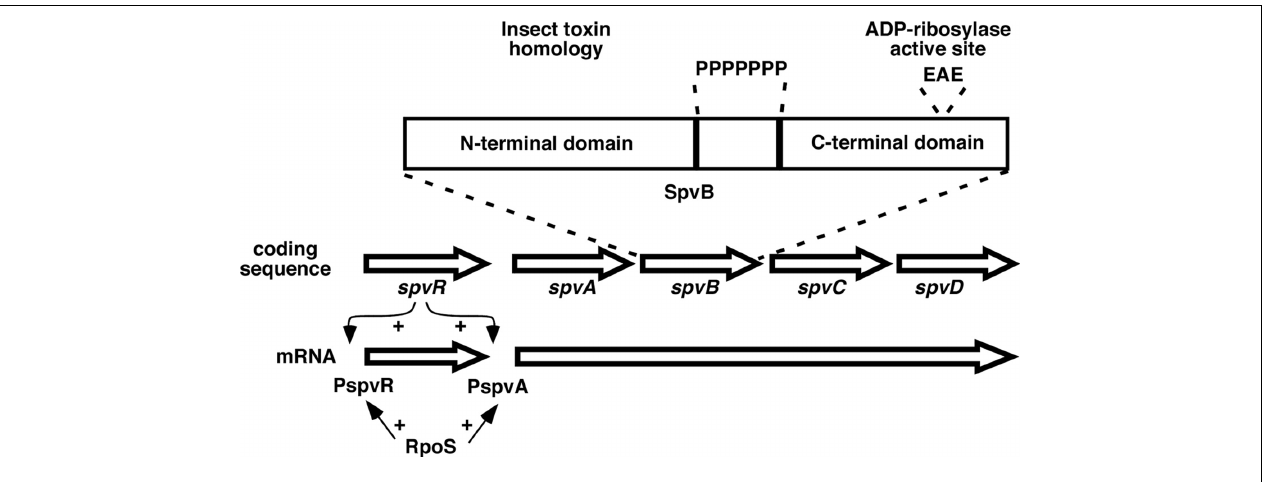
FIGURE 1 | Map of the spv region found on virulence plasmids in subspecies 1 strains, not drawn to scale. The spvR gene is transcribed separately from the spvABCD genes. SpvR activates transcription at both promoters in concert with the RpoS sigma factor.